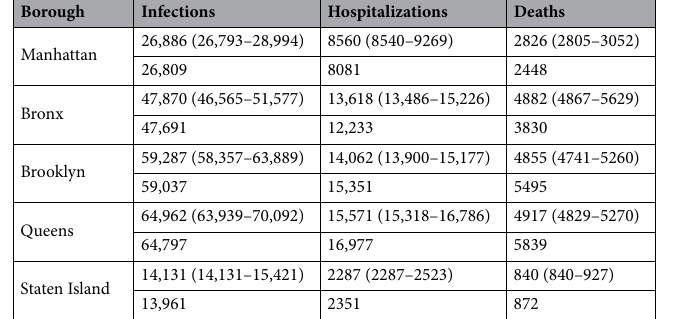
Table 3. Model predictions and reported accumulated infections, hospitalizations, and deaths for the boroughs of NYC on 01-July-2020. Top rows represent predictions and bottom rows are reported cases. Inside the parentheses are the 90%